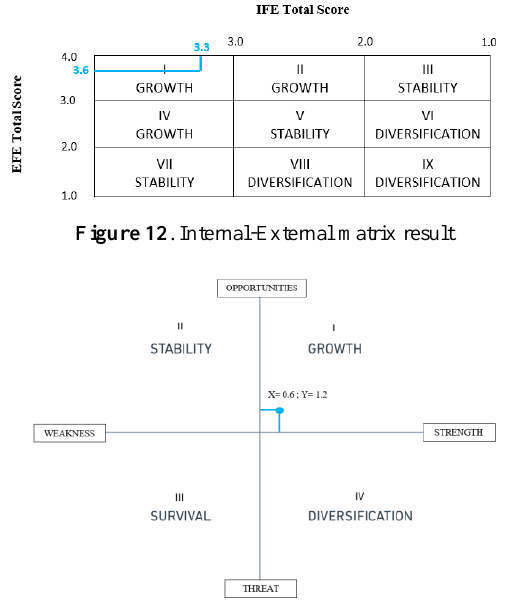
Figure 13 . SWOT-4K matrix